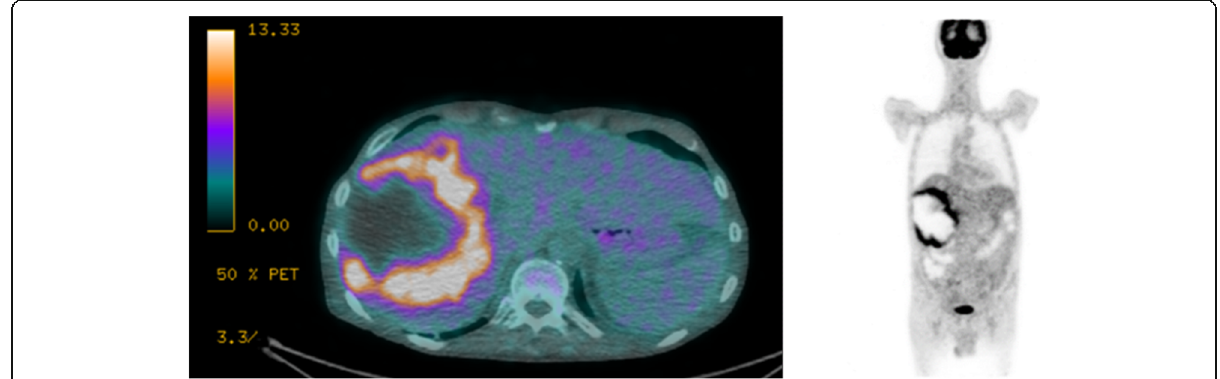
Fig. 4 PET imaging, fusion PET/CT, and PET coronal view showing the high uptake of liver mass. The difference between inner and outer part of the mass are highlighted